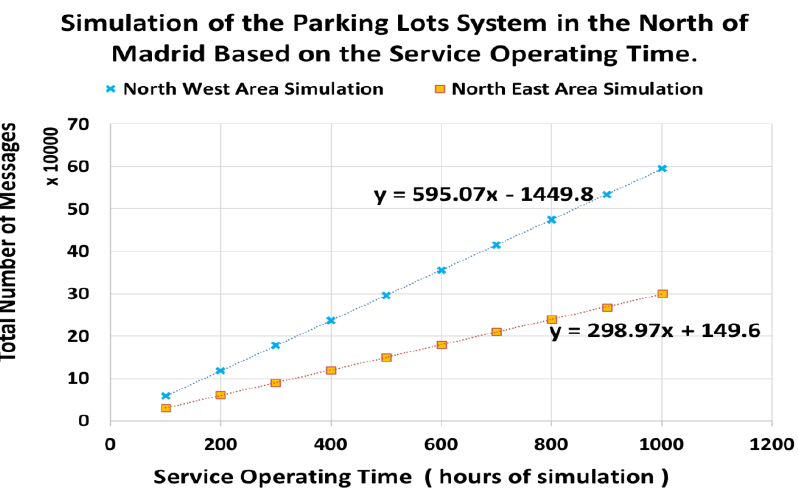
Figure 27. A linear relationship between the total number of messages sent to the cloud platform by simulators and the number of simulated hours of service operation.